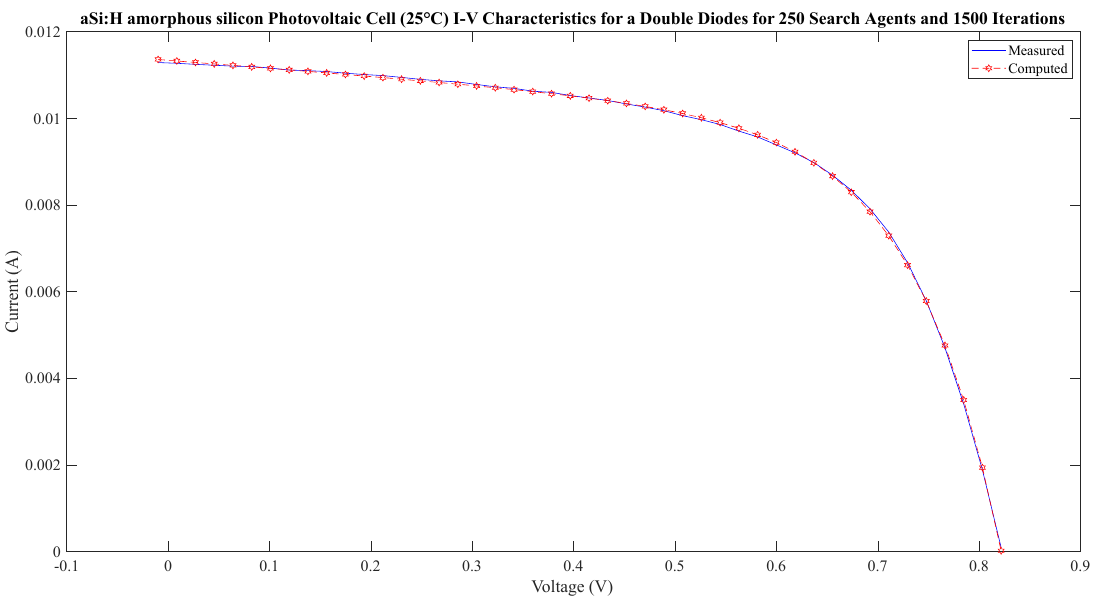
Figure 6. The current-voltage characteristics of amorphous silicon photovoltaic cell (DDM). PWP 201 photovoltaic panel current-voltage characteristics, measured and calcu- lated, are presented in Figure 7 for the SDM model and in Figure 8 for the DDM model. The matching between the characteristics is very good. This is proven by the high values, for both models, of the coefficient of determination over 0.99996, and the adjusted coeffi-